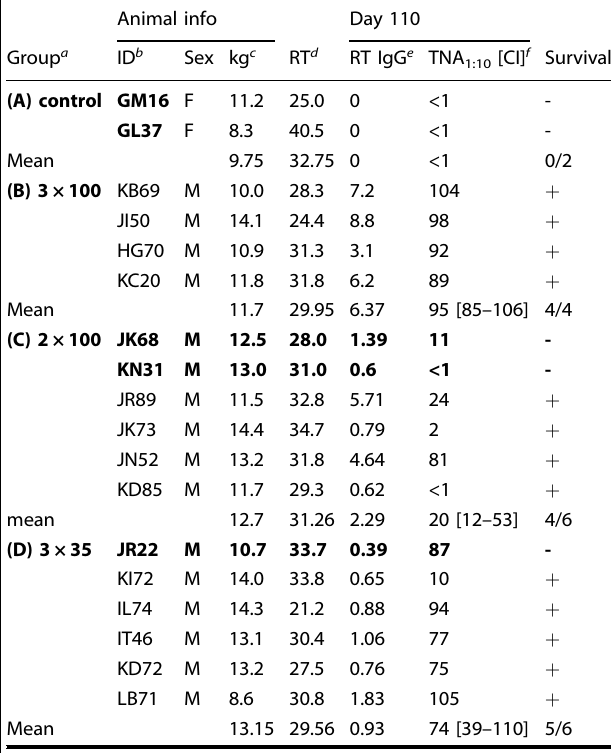
Table 1. RiVax vaccination groups and outcome following RT challenge.